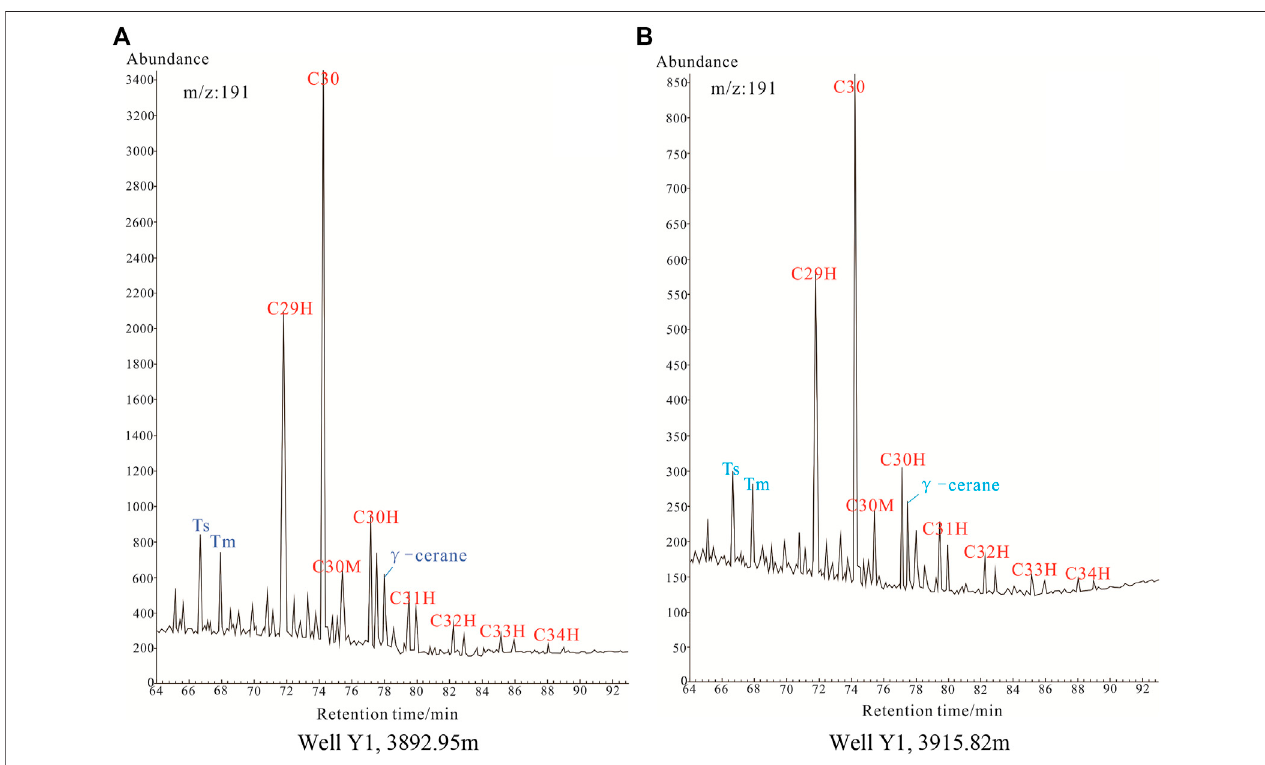
FIGURE11| Crossplot ofPr/nC 17 and Ph/nC 18 ofJ 1 da 2 shalesamplesfrom well Y1(modi fi ed from Aliaset al.,2012; Yuet al.,2021). (A) Well Y1,3,892.95 m. (B) Well Y1, 3,915.82 m.